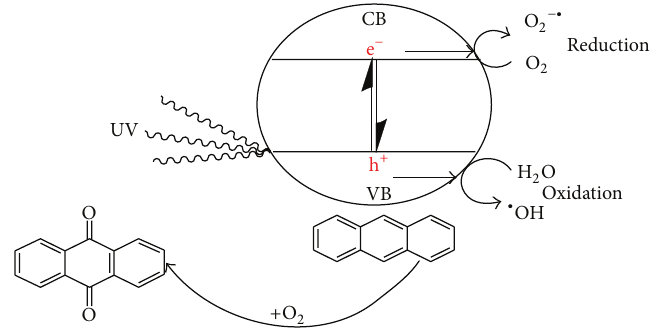
Scheme 1: Mechanism diagram of photocatalytic degradation for